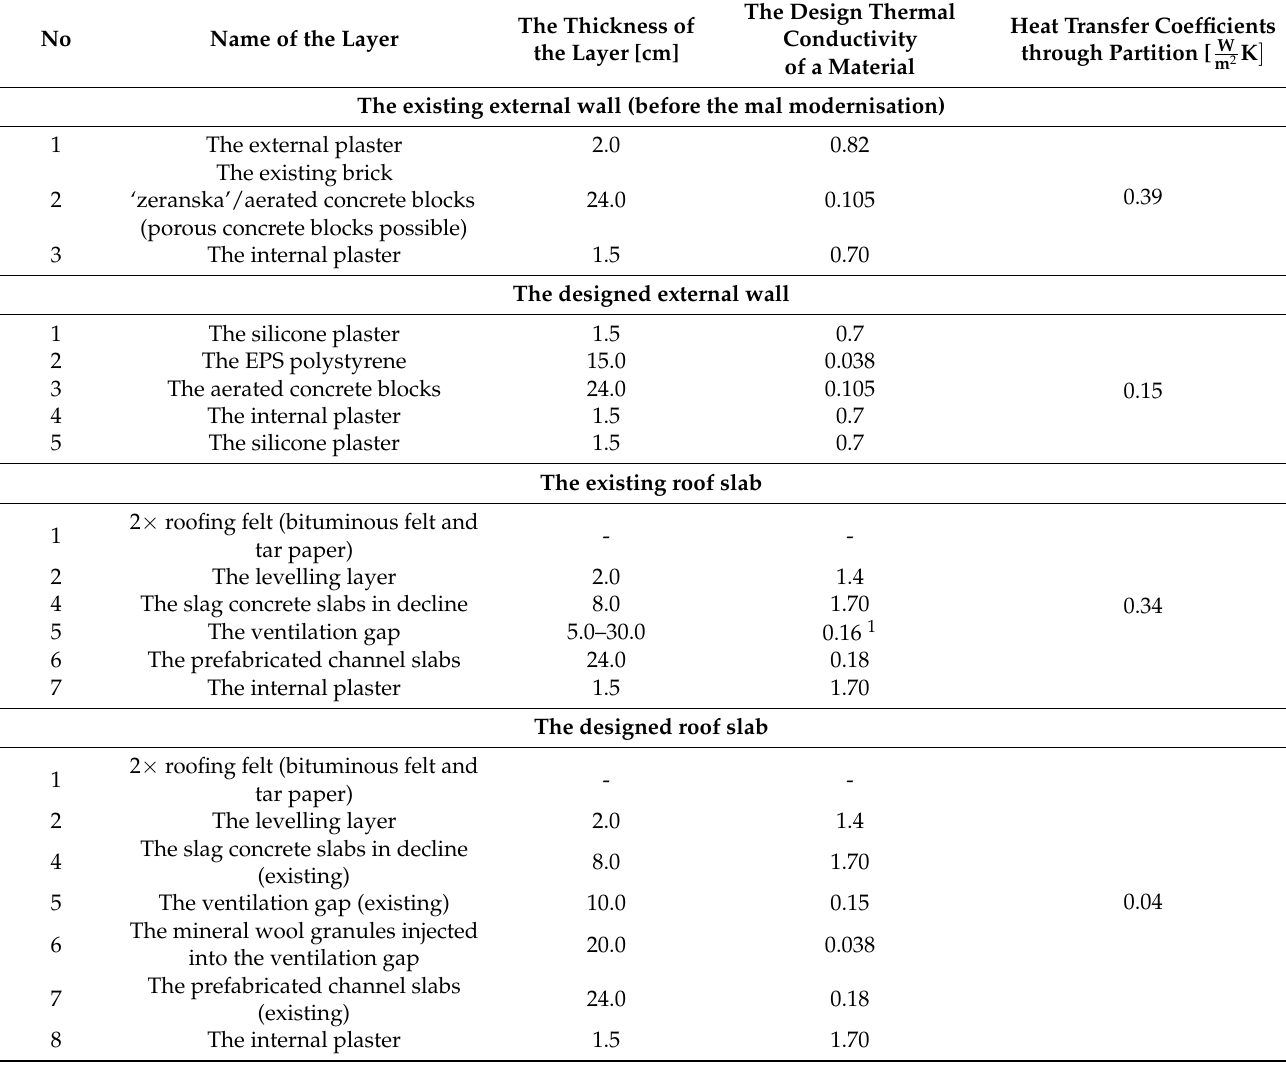
Table 1. The thermal modernisation building solutions for the block by Nankiera square (elaborated by the Authors based on [18]).